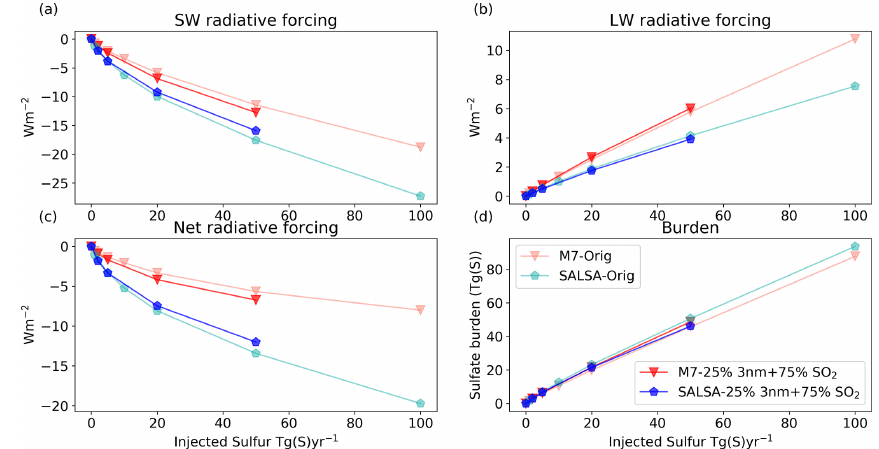
Figure A1. Global mean (a) short-wave, (b) long-wave and (c) total radiative forcing as well as (d) the stratospheric sulfate burden as a function of injection rate. M7 results are shown in red, and SALSA results are shown in blue. The lighter dashed lines correspond to original simulations, and the darker solid lines represent the corresponding simulations without nucleation.